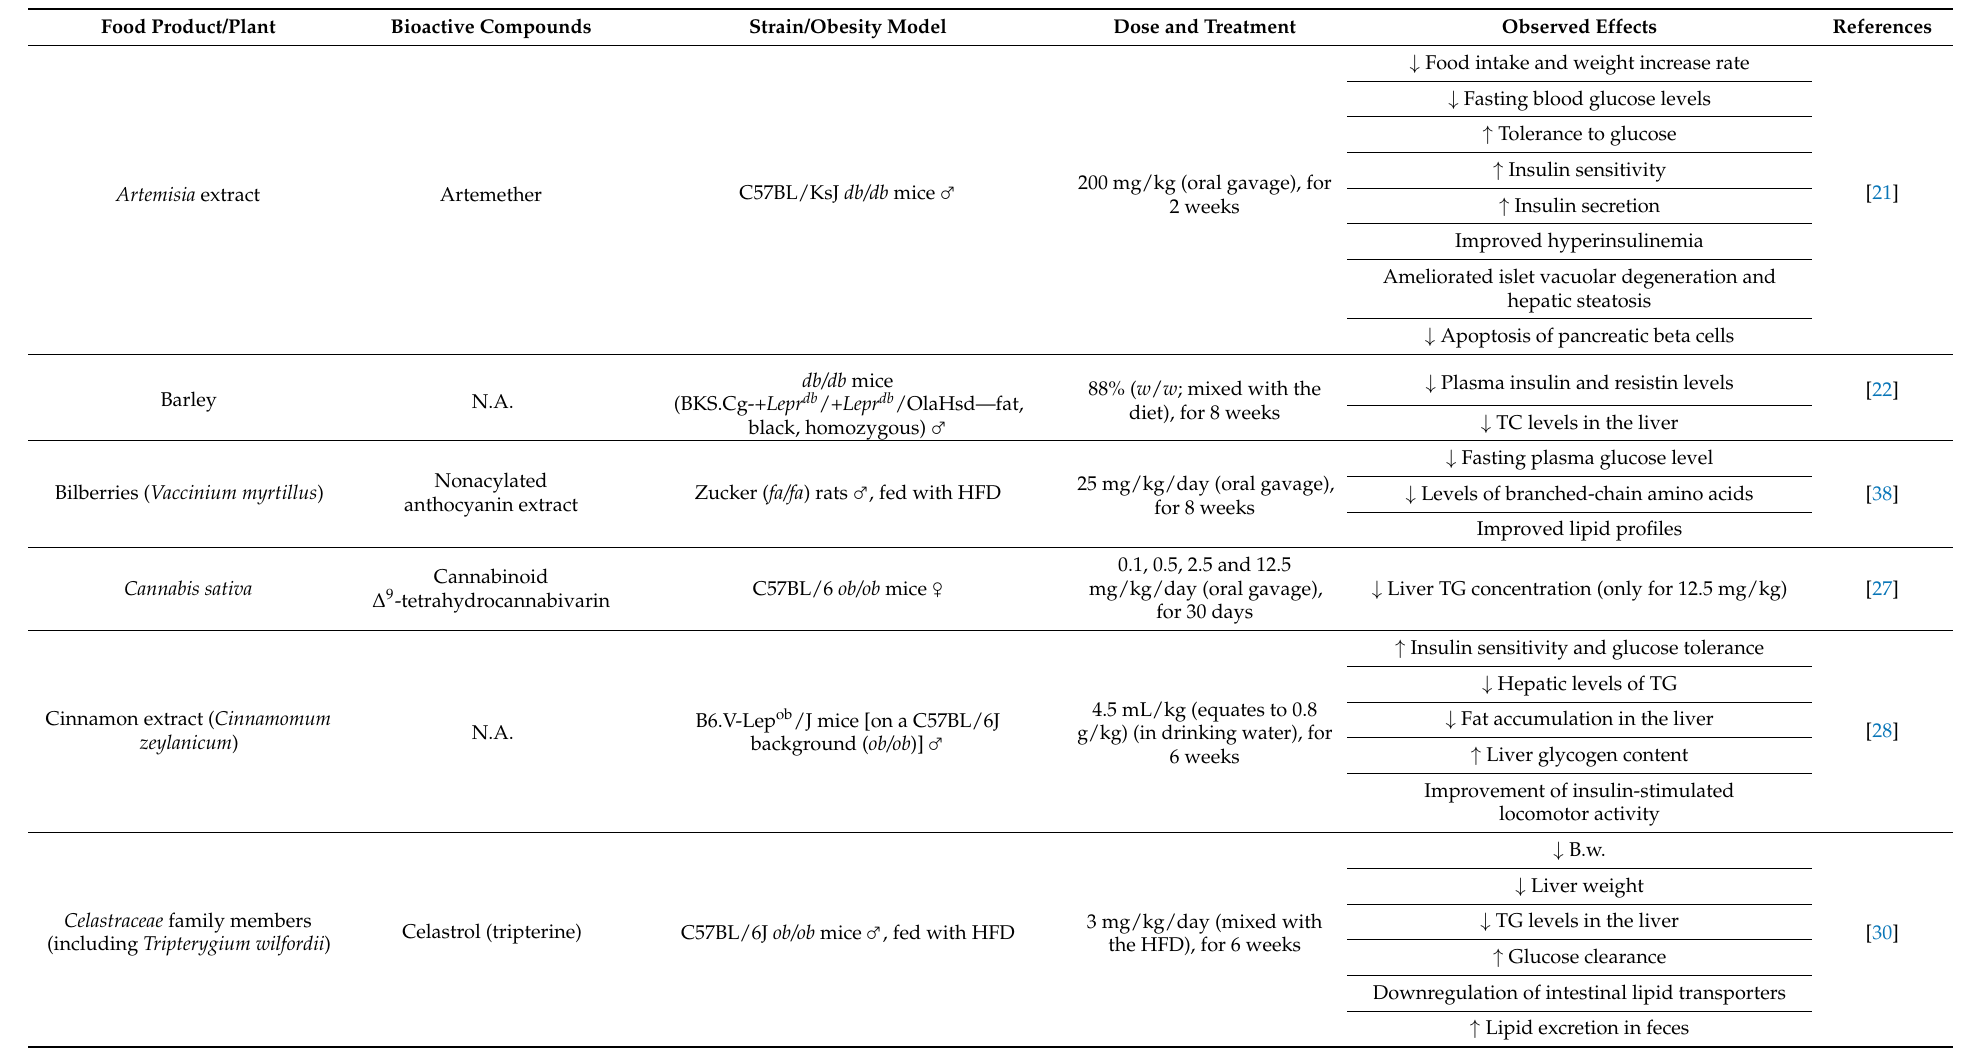
Table 1. Anti-obesity effects of natural products in monogenic and neurotoxin monosodium glutamate (MSG)-induced obesity